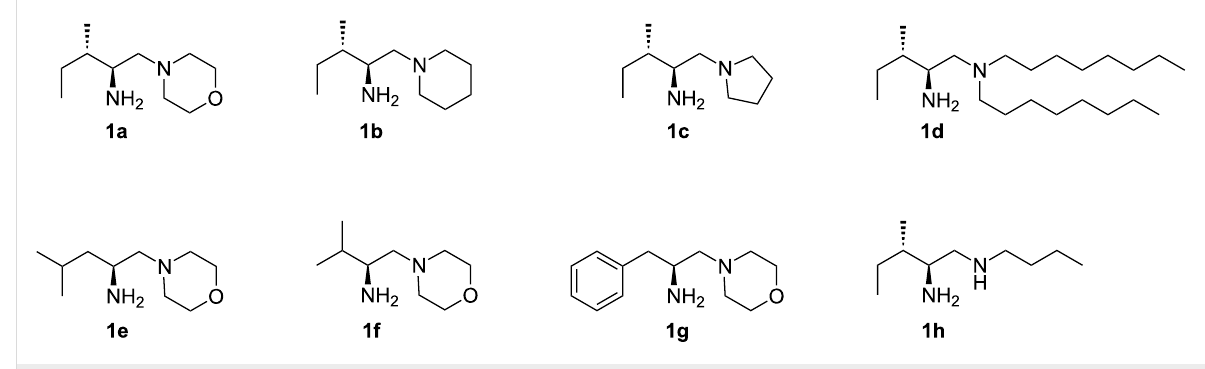
Figure 2: Primary-tertiary diamine organocatalysts.